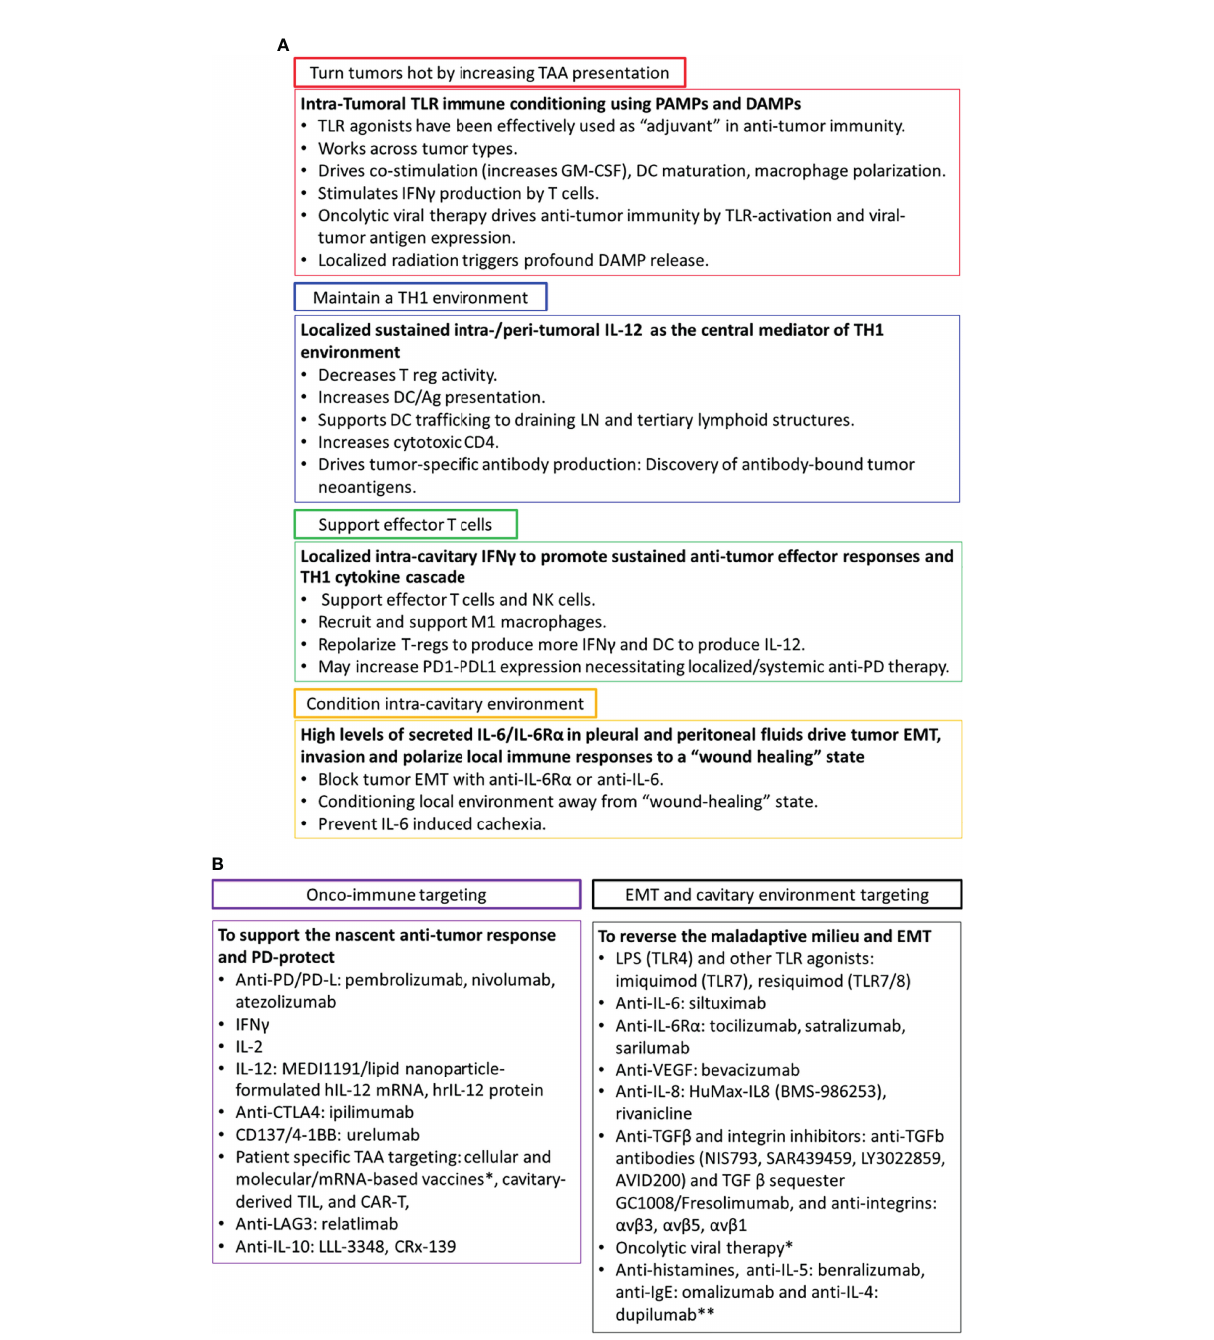
FIGURE 2 | Intra-cavitary therapeutics to drive systemic immunity and reverse EMT. Panel (A) Since tumors that metastasize to the pleural and peritoneum exist in an environment tailored to EMT and immune suppression, combination therapy directed toward conditioning the local environment as well as activating anti-tumor immunity is required. Panel (B) A list of potential therapeutics directed toward reversing tumor EMT, repolarizing the cavitary maladaptive milieu, and driving local and systemic anti-tumor immunity. *Summarized in Addeo et al. (21) **Targeting histamine and related cytokines. Discussed in Li et al. cytokines (40, 41), upstream of a wide array of in fl ammatory Our secretomic data supports the role of IL-6/sIL-6R a receptor processes, including pathologies as diverse as cytokine release trans-signaling as the key driver of tumor EMT and associated syndrome (42), acute allograft rejection (43), rheumatoid arthritis therapy resistance and increased metastatic potential. IL-6 and its (44), asbestosis (45) and cachexia (46). Complexes of soluble secreted receptor sIL-6R a are increasingly recognized as master